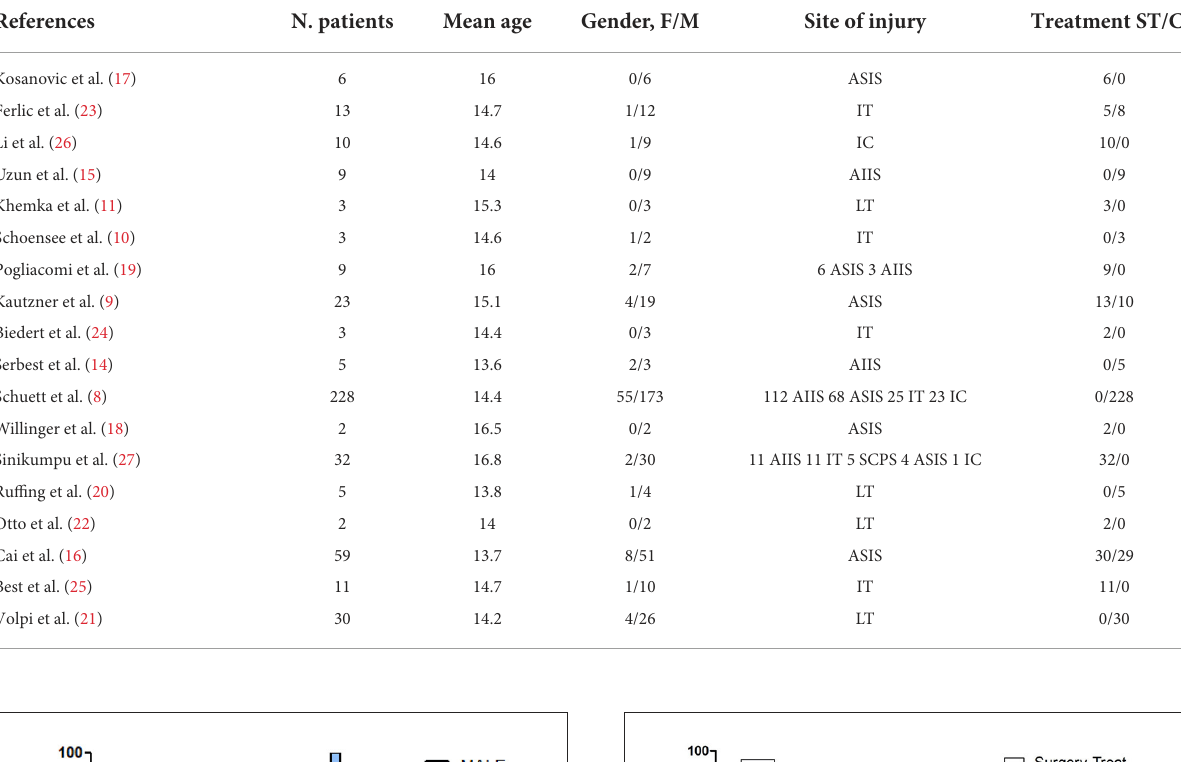
TABLE 1 Patient’s demographics and study characteristics.